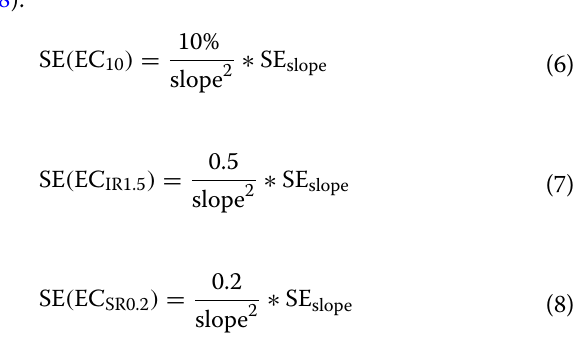
: Concentration causing a suppression ratio of 0.2 SR0.2